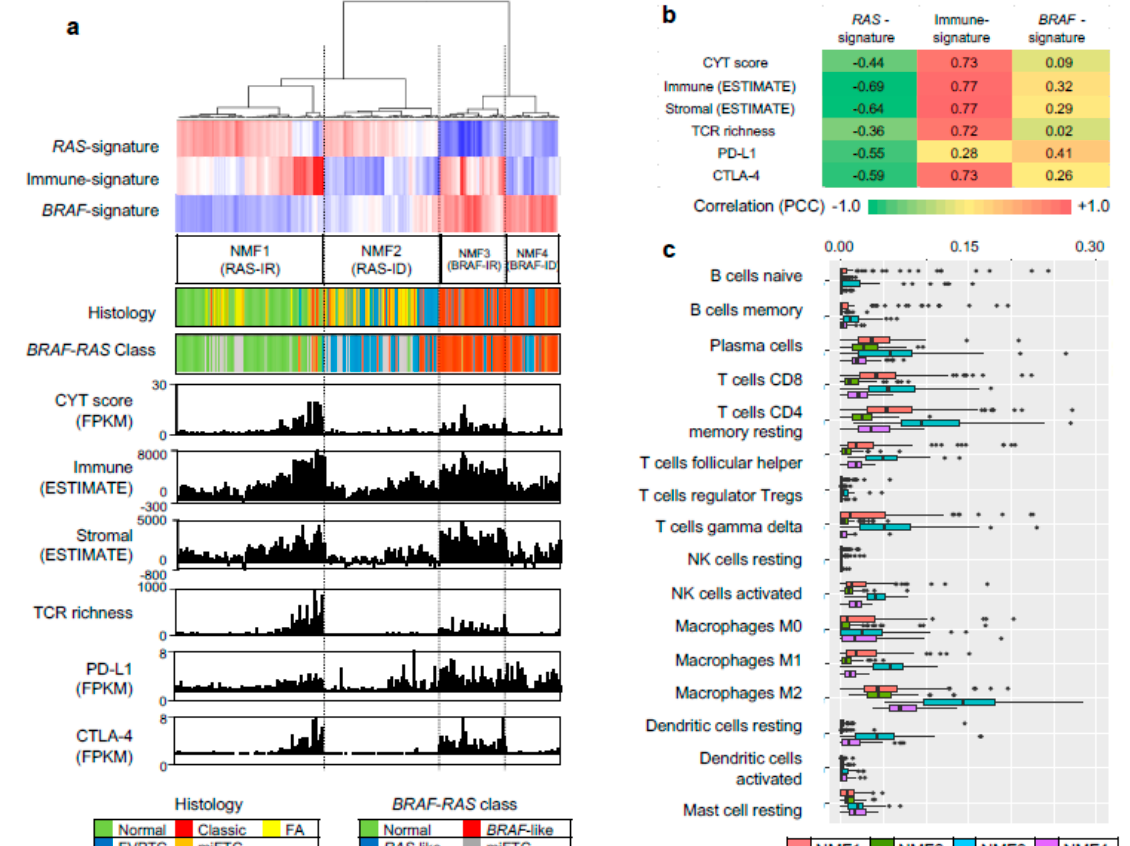
Figure 5. NMF clusters and immune features of CMC cohort. ( a ) Four NMF clusters determined by metagene projection of three metagene signatures for 41 thyroid profiles of CMC cohort. Five histological types and mutation-based BRAF -/ RAS -like classes are shown with corresponding legends below. Six immune-related features are shown, including CYT score, immune/stromal ESTIMATE scores, TCR richness, and expression levels of PD-L1 and CTLA-4; ( b ) A heatmap showing correlation levels between three metagene signatures and six immune features; ( c ) Abundance of 10 immune cell subsets ( p < 0.05; ANOVA test) with respect to four NMF clusters. Cancers 2018 , 10 , x